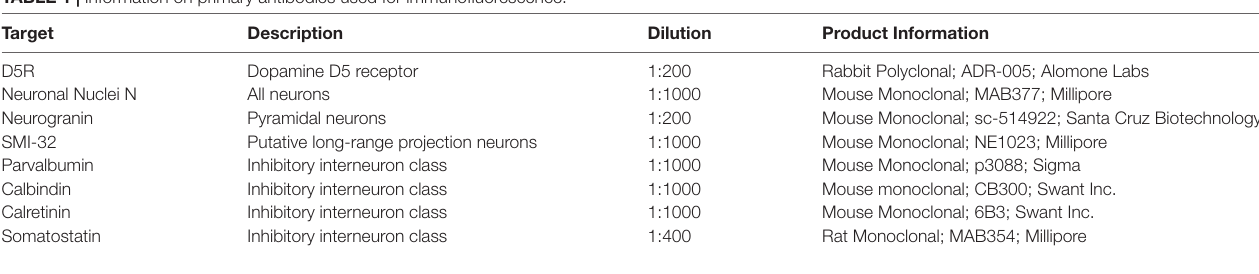
TABLE 1 | Information on primary antibodies used for immunofluorescence.